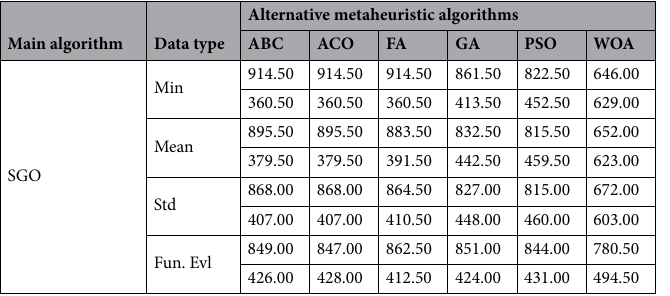
Table 6. The MW test outcomes (summation of ranks) of different metaheuristic algorithms.